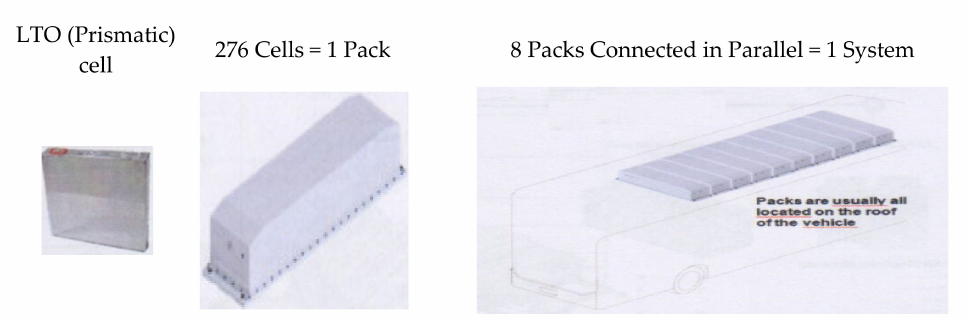
Figure 8. The installations of the LTO (prismatic) type